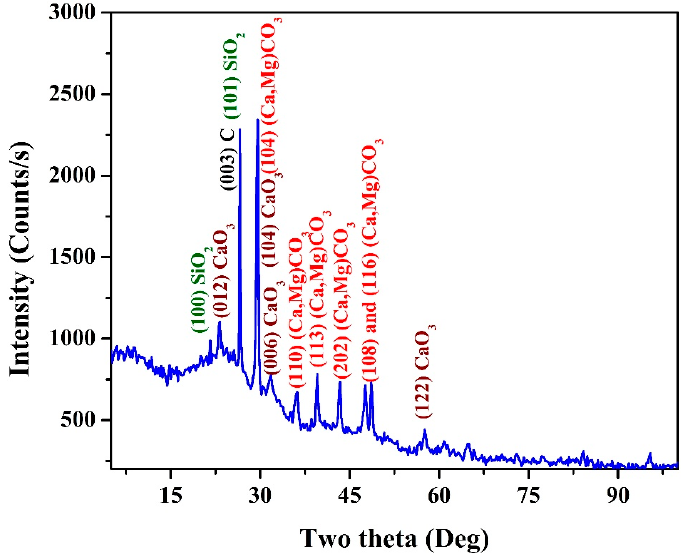
Figure 4. XRD pattern for a powder produced from hydrothermal treatment using 1.0 M KOH at 170 °C for 3 h and calcined at 600 °C. In XRD analysis, the prominent peaks representing graphite and graphene are close.